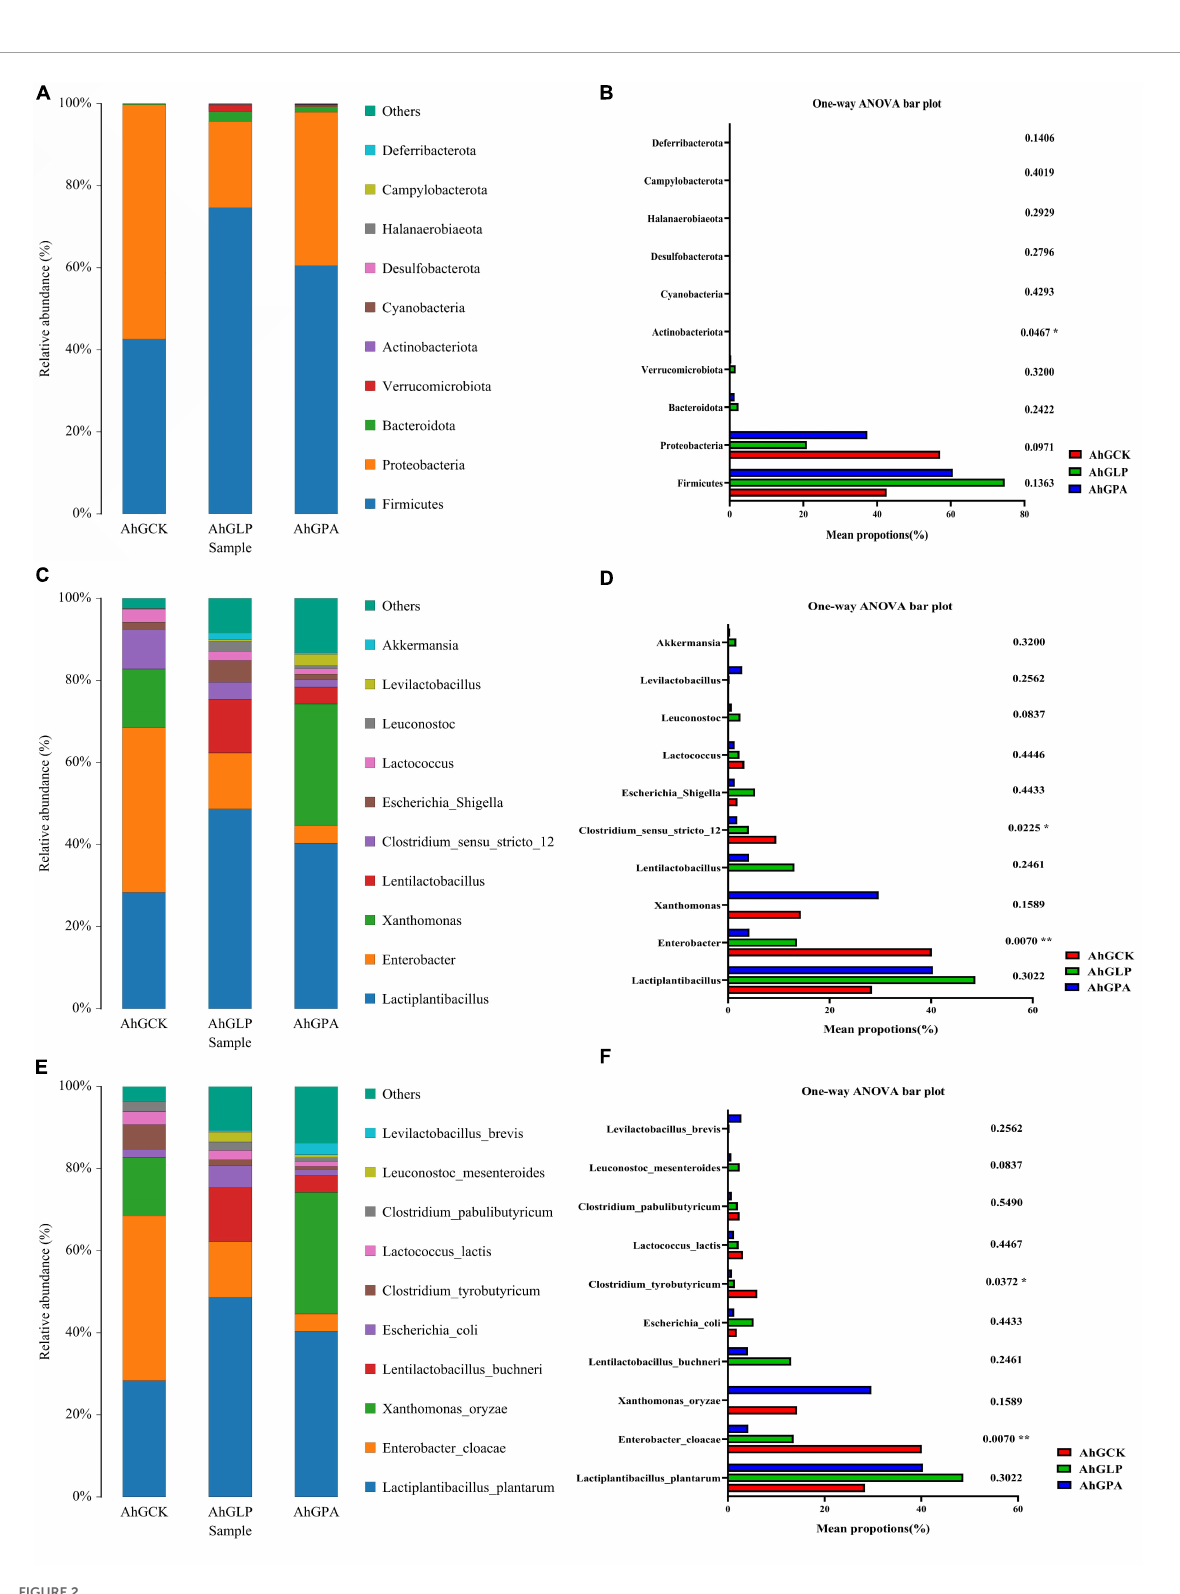
FIGURE2 Relative abundance of bacteria at the phylum (A) , genus (C) , and species (E) levels in high-moisture amaranth silage with Lactobacillus plantarum and propionic acid additives. The extended error bar plot displaying the significant differences among groups at the phylum (B) , genus (D) , and species (F) levels. AhGCK, control; AhGLP, L. plantarum ; AhGPA, propionic